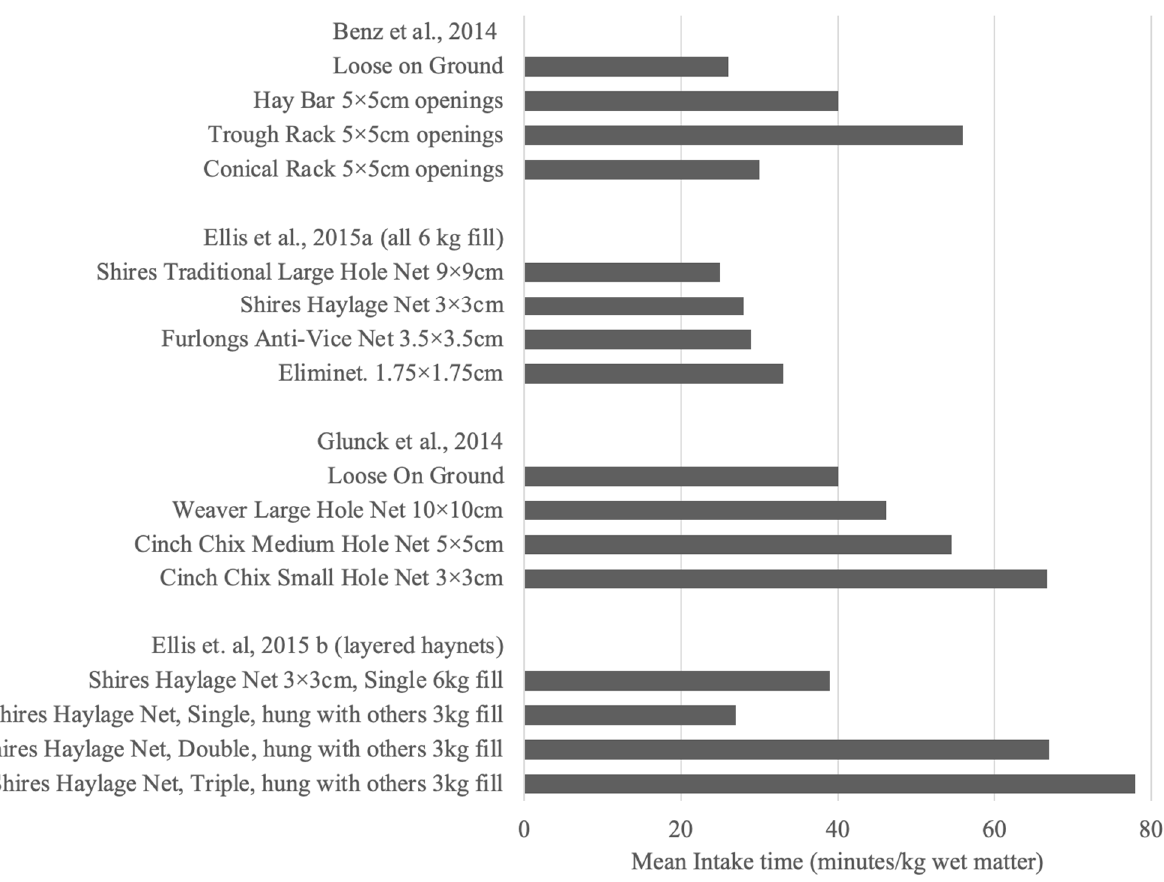
Figure 1. Mean Intake time (minutes/kg wet matter of hay) for horses when eating hay from various different haynet types or similar feeding devices [3,4,6,8]. different haynet types or similar feeding devices